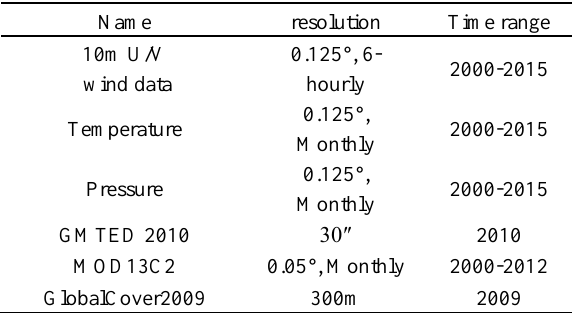
Table 1. The specific information of data